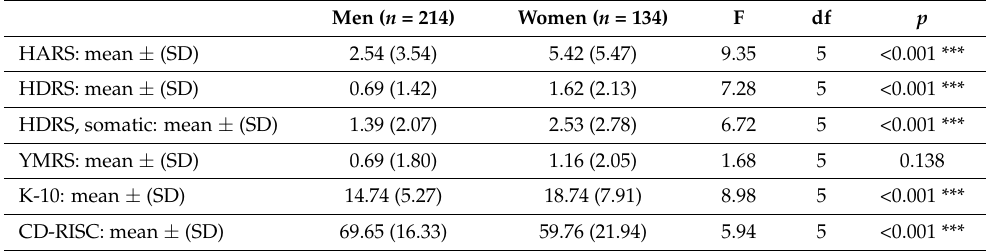
Table 2. Variables resulting from the psychometric assessment of the sample ( n = 348), according to gender.